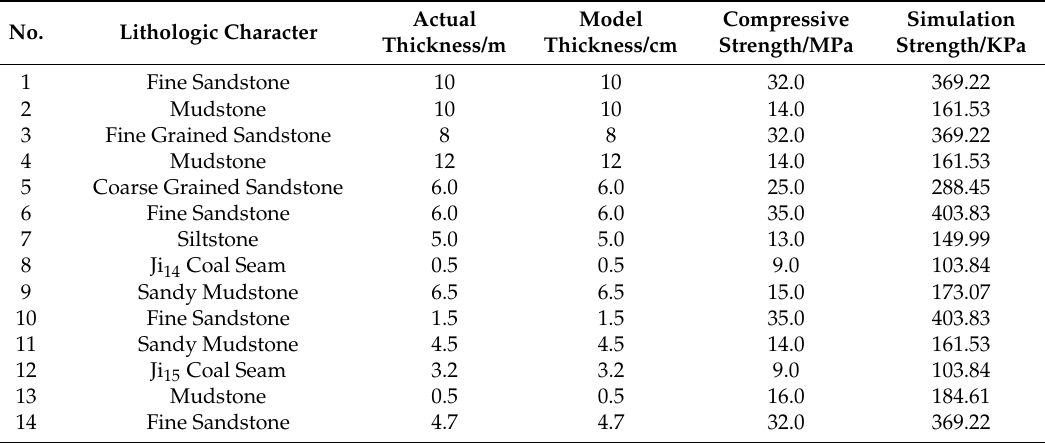
Table 2. Physical simulation parameters of the test model.